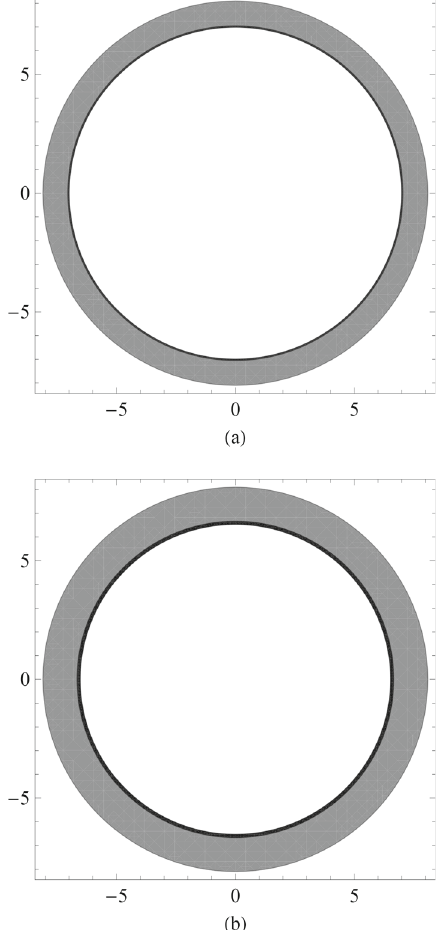
Fig. 20 Cross sectional view of the star HER X-1 for different stability regionofquarks.Hereinnerregionmarkedwithwhitecolourrepresents stable quark relative to 56 Fe above which a thin layer of metastable quark exists which is shown in black colour and the outer layer in gray colour consists of unstable quarks. Figure in the top panel ( a ) is plotted without charge ( γ = 0) and in the bottom panel ( b ) we consider the effect of charge and take γ = 0 . 2. The pressure anisotropy ( α ) is set to